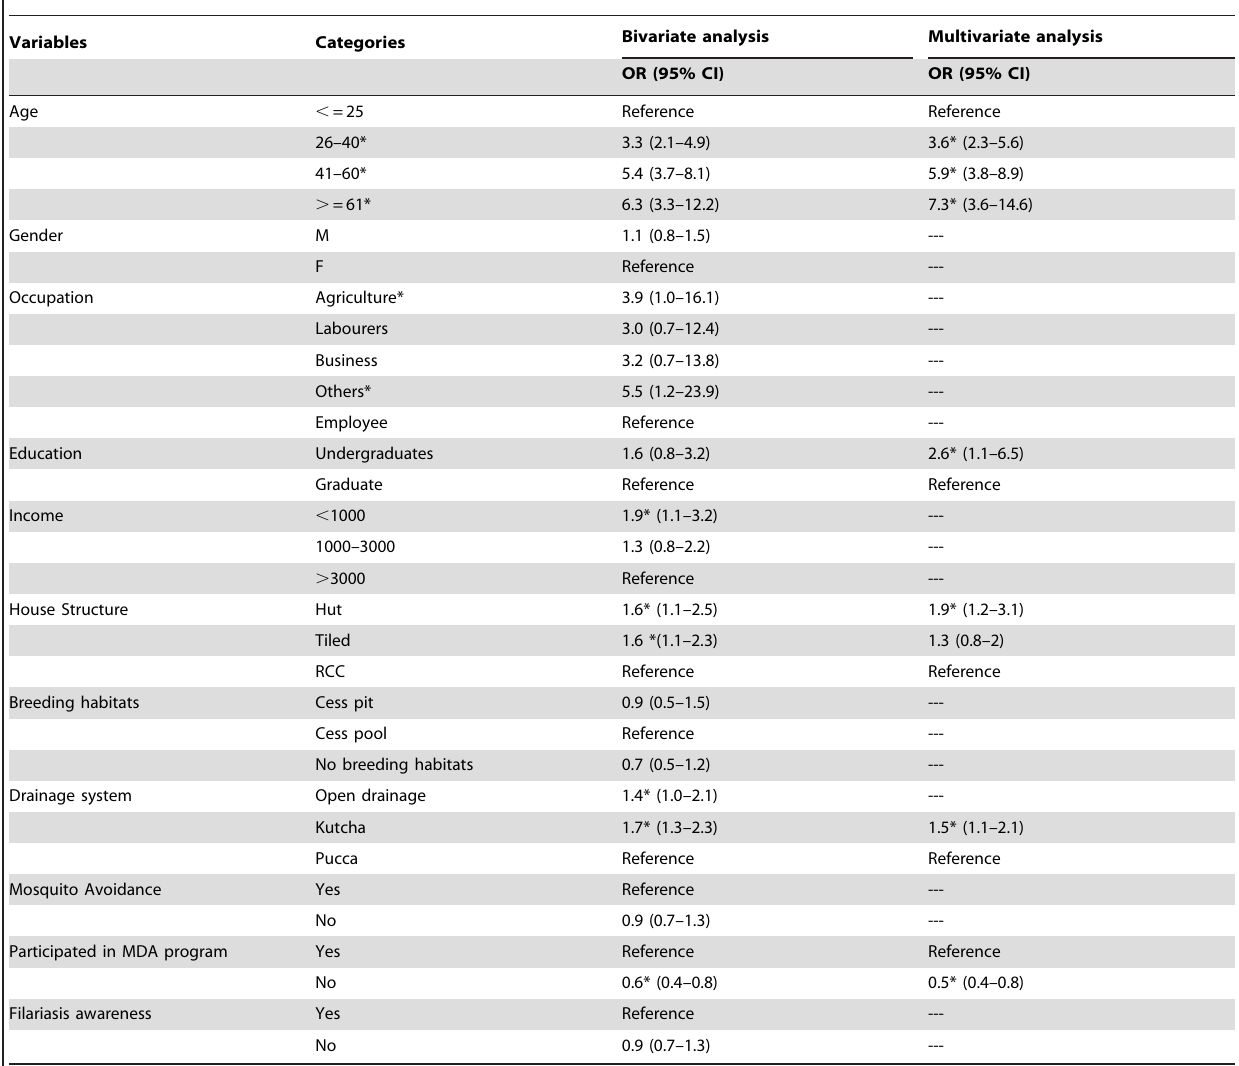
Table 2. Bivariable and multi variable analyses of predictors of observance to a filaria cases and socioeconomic survey participants from villages of Karimnagar district of Andhra Pradesh